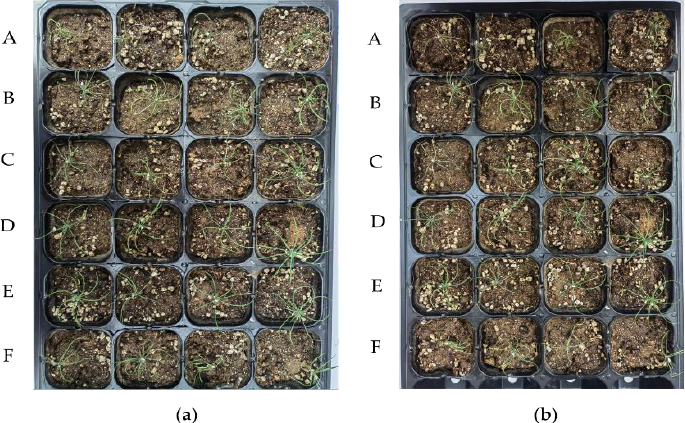
Figure 10. Effect of 2-coumaranone and cyclo-(Phe-Pro) on inhibit PWN in vivo. A–F groups were treated with 5% DMSO + PWN, 2-coumaranone + PWN, cyclo-(Pro-Phe) + PWN, 5% DMSO, 50 mM 2-coumaranone, and 50 mM cyclo-(Pro-Phe), respectively. ( a ) Pine seedling symptoms on day 9 in different treatment groups; ( b ) pine seedling symptoms on day 12 in different treatment groups.